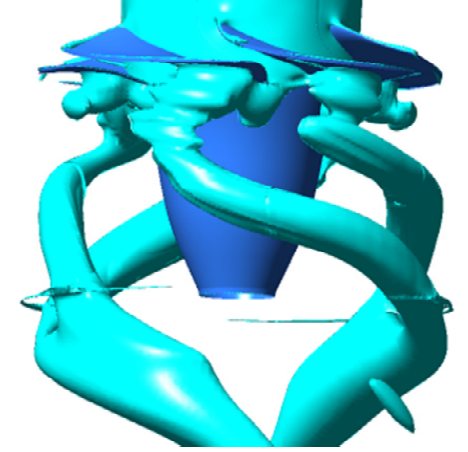
Figure 17. Evolution of the pressure iso-surface at 205 kPa.